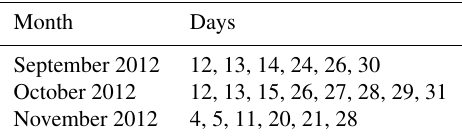
Table 1. The 20 case studies. Month